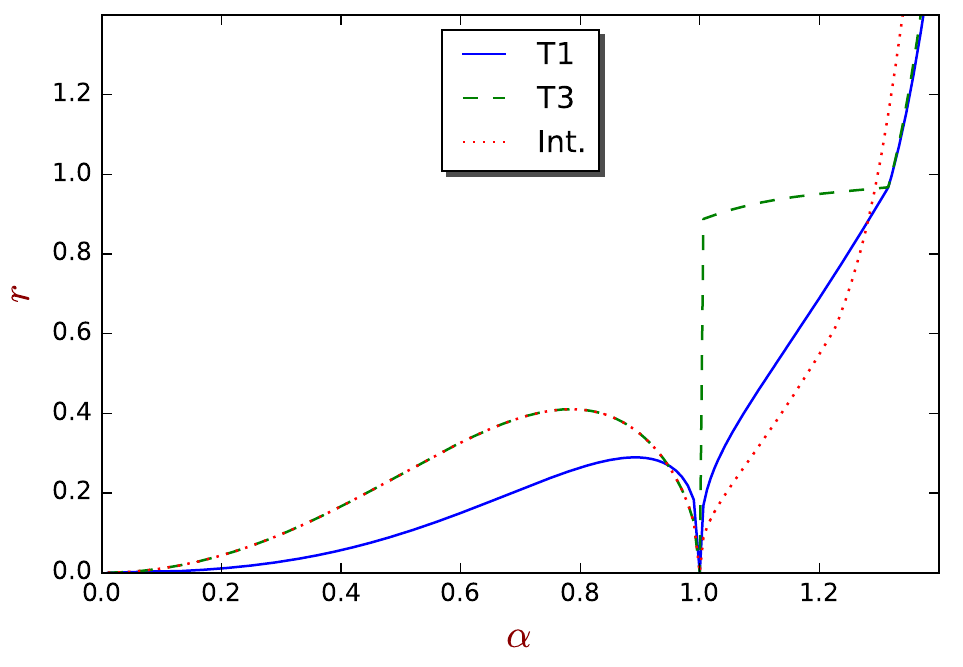
Fig. 4 Spectral radius of the AM4 methods for T1, T3 and interpolation techniques